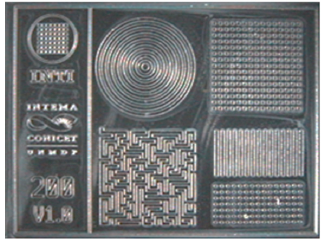
0 μ m structures.